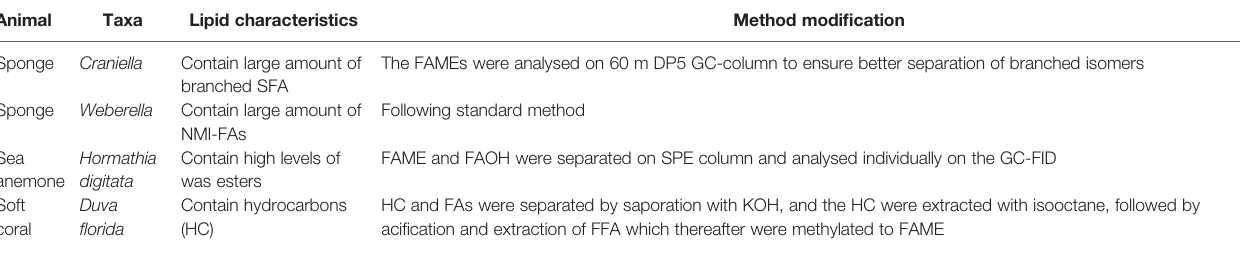
TABLE 1 | Method modi fi cation of fatty acid and fatty alcohols analysis per